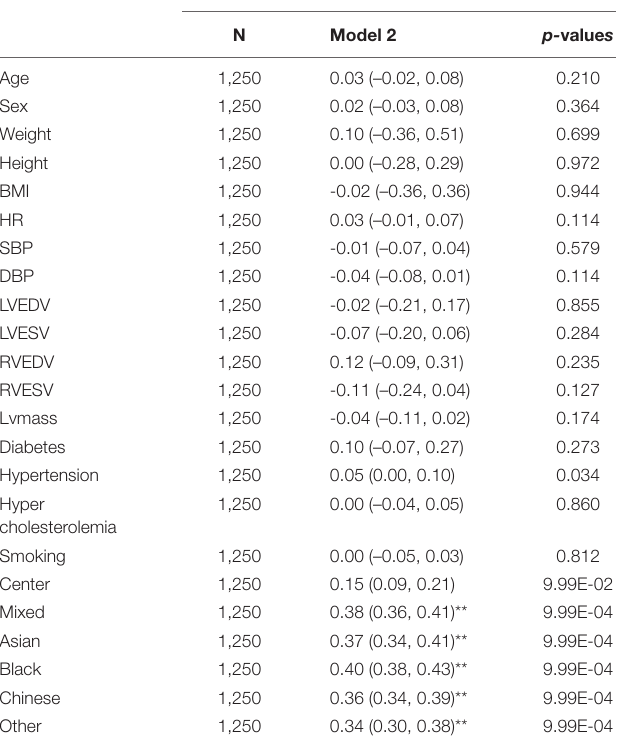
TABLE 5 | The comparison of adjusted mean between racial groups based on one-way ANOVA and